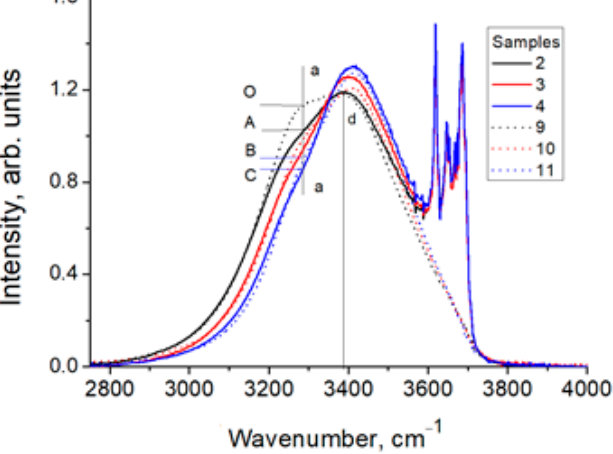
Figure 15. IR spectra of moistened kaolinite samples and the solutions used for moistening in the range of 2750–4000cm − 1 . See text for details.